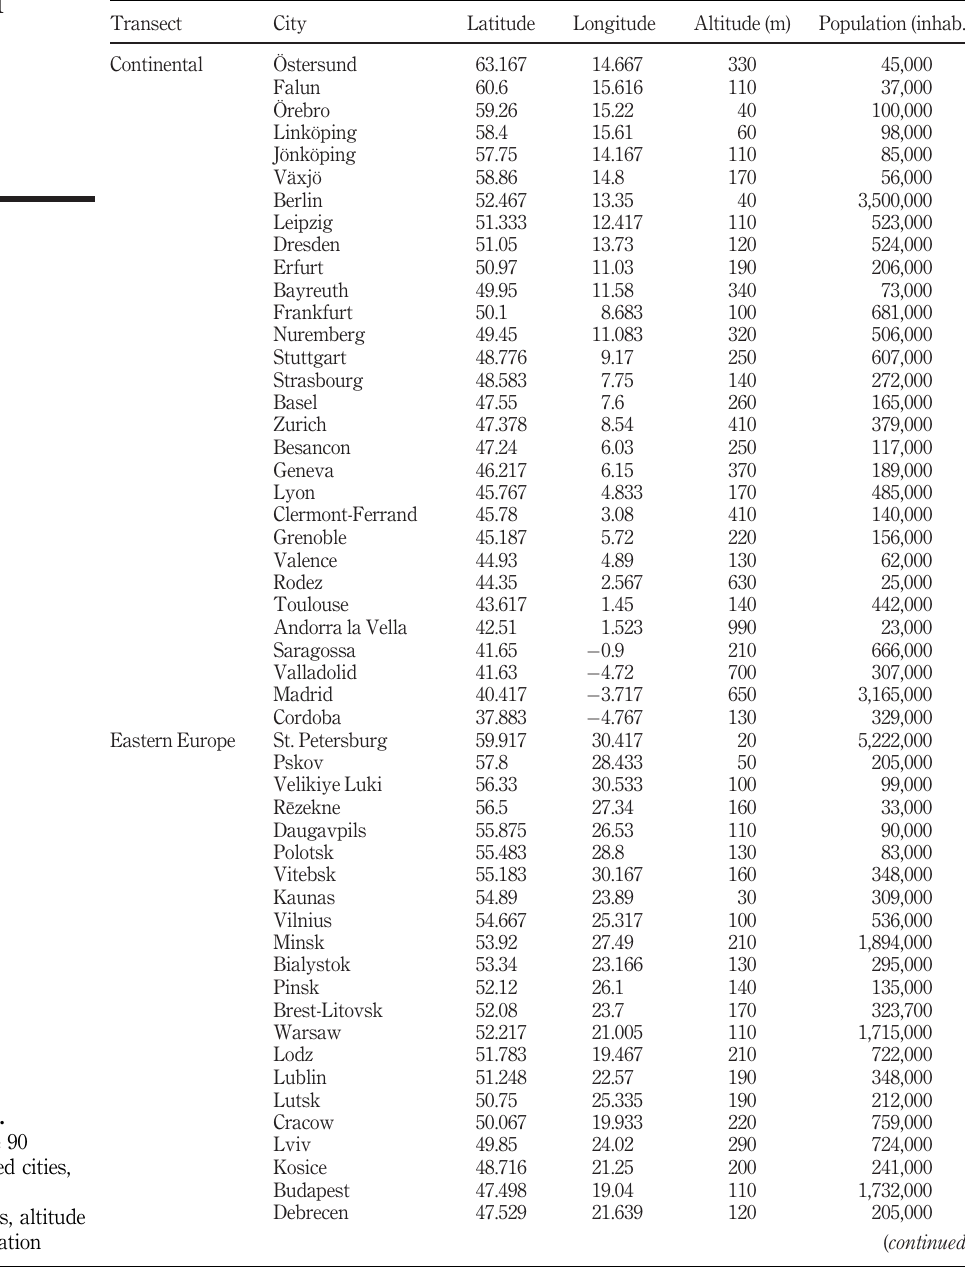
Table AI. List of the 90 investigated cities, with their coordinates, altitude and